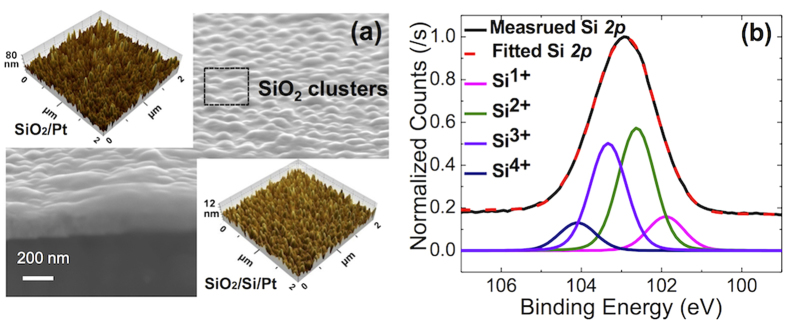
(a) The bird’s eye view SEM image of the sputtered SiO2 on Pt film. The upper and the lower inset figures are the AFM image of SiO2/Pt and SiO2/Si/Pt, respectively. (b) The XPS results of Si2p core-level spectra of SiO2/Pt.